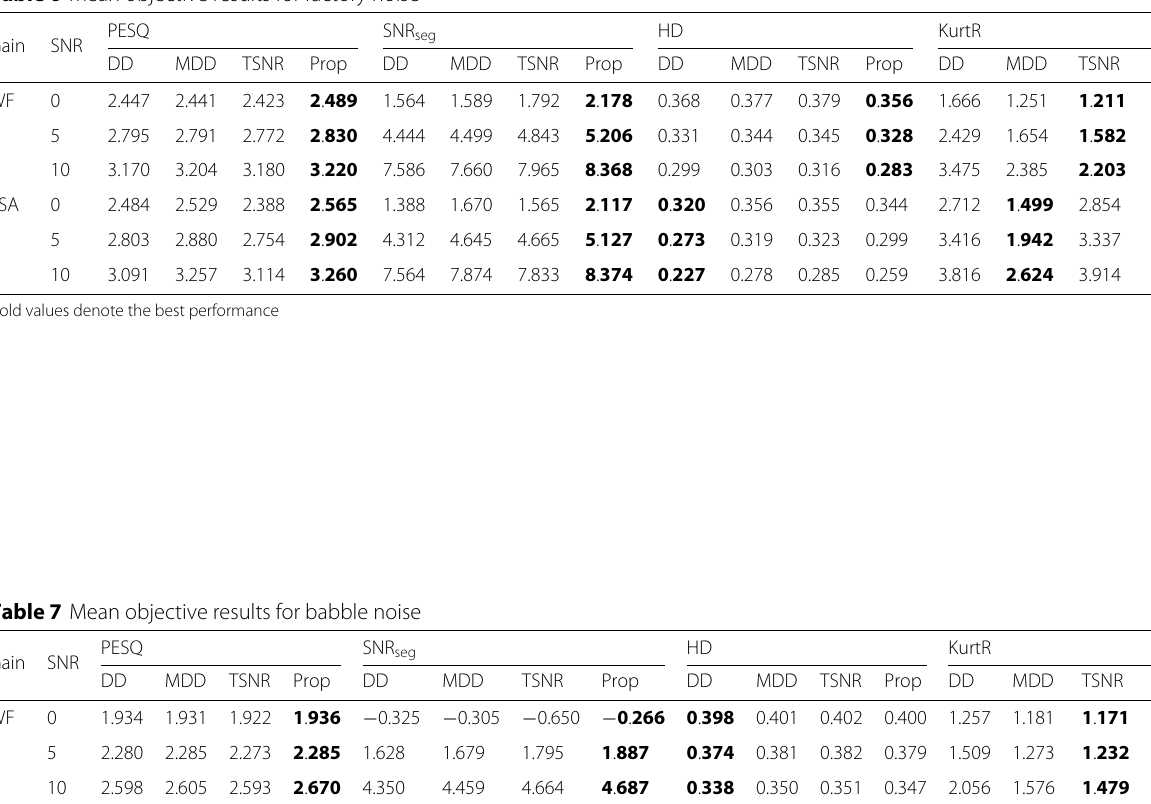
Table 6 Mean objective results for factory noise